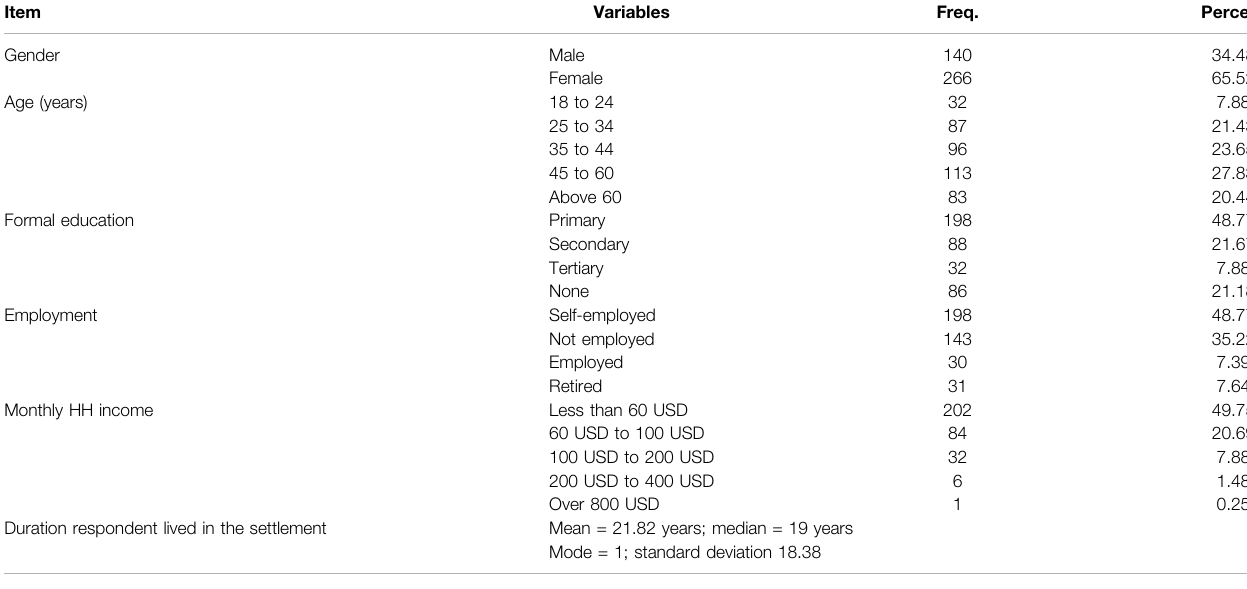
TABLE 1 | Sociodemographic characteristics of the respondents.